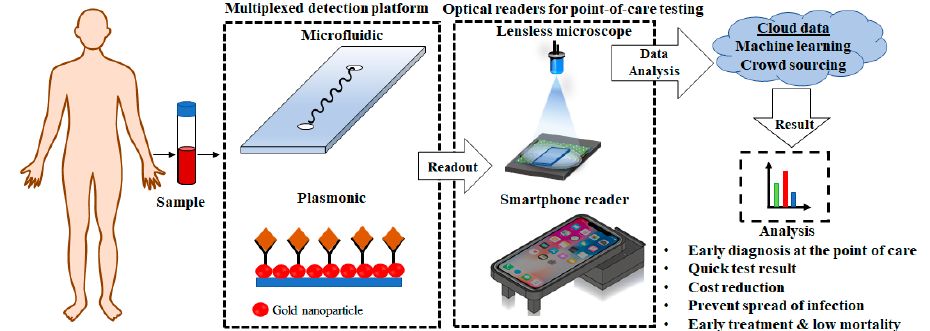
Figure 1. Flow diagram showing the process of sample testing using point-of care devices.